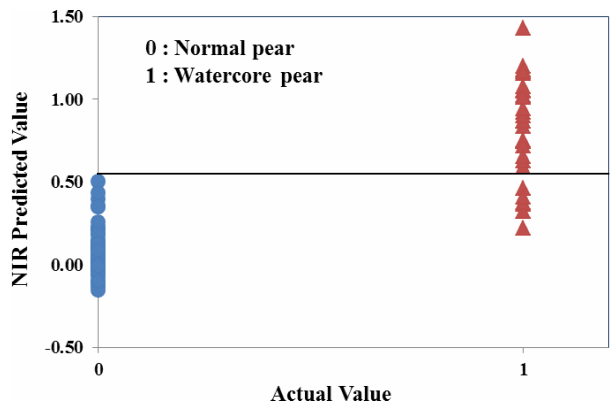
Fig. 7. Original spectra of some samples measured in the wavelength 700 – 850 nm. Black lines indicated accepted normal pears, and gray lines represented rejected watercore pears.